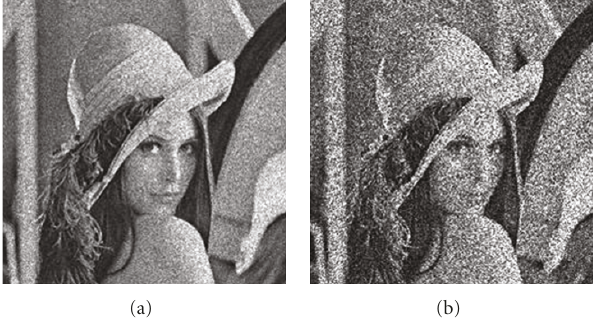
Figure 2: The degraded “Lena” image with L = 33 (a) and the degraded “Lena” image with L = 5 (b).